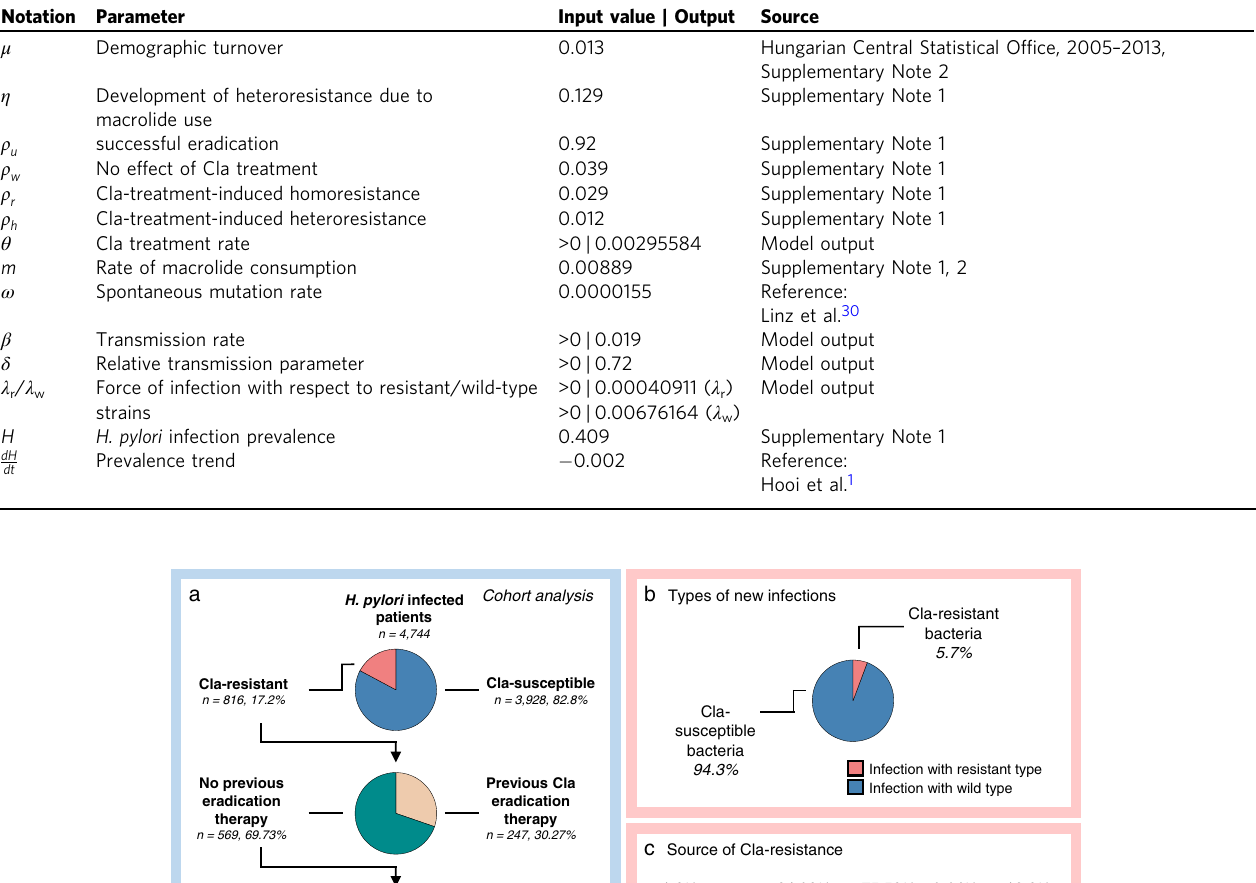
Table 3 Parameters and results (outputs) of the mathematical model.